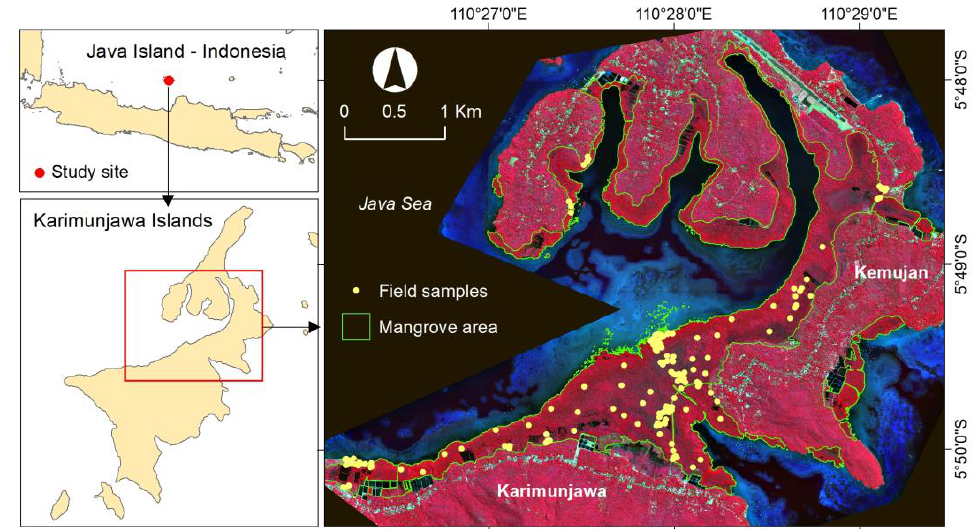
Figure 1. Study area map—The Karimunjawa and Kemujan Islands displayed on a Landsat 8 OLI color composite image with RGB 546 band combination.